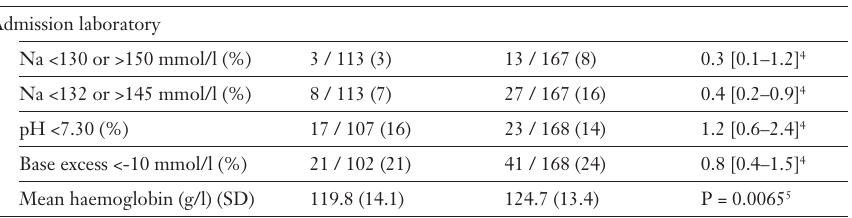
Comparison between community-acquired RV hospitalisation episodes in non- Swiss and in Swiss children <5 years of